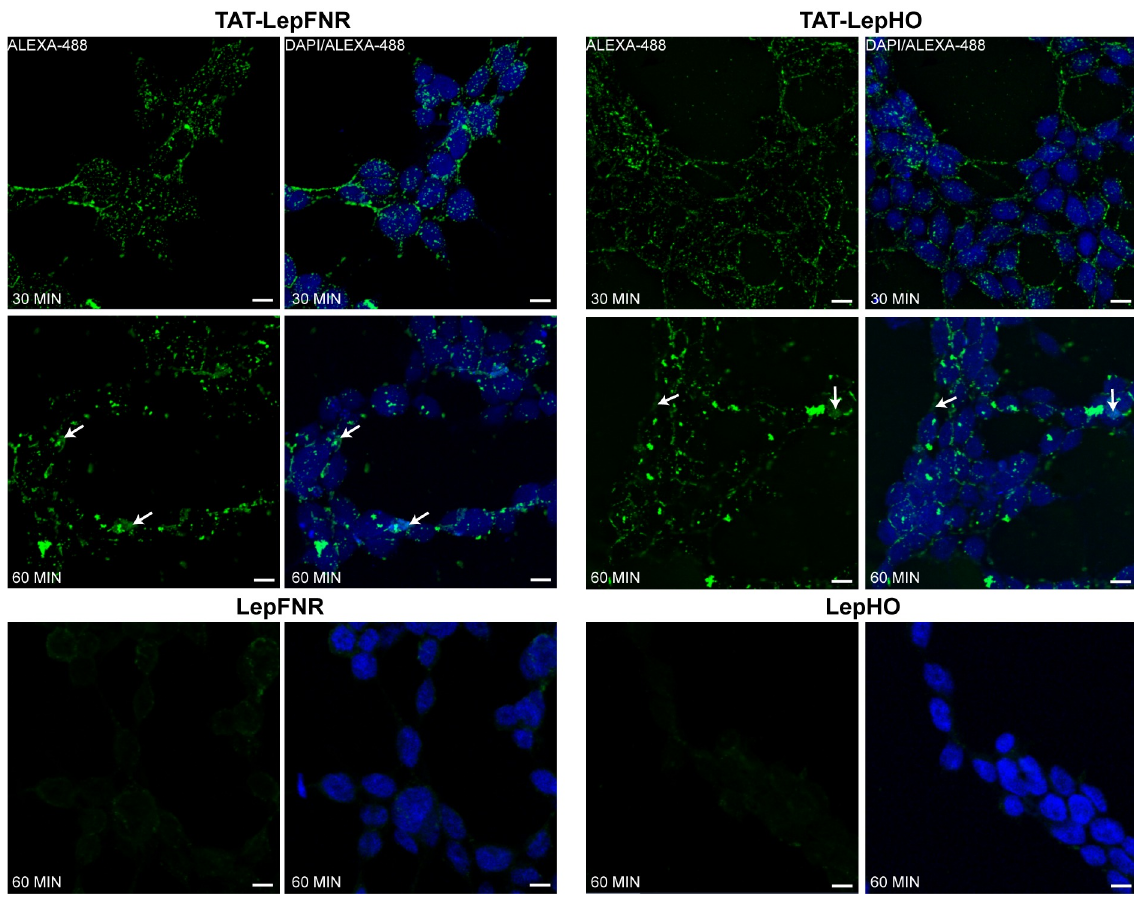
Fig 4. Immunofluorescencedetection of transduced proteins. Cells were incubatedwith 3 μ M TAT-LepHO/TAT-LepFNR for 30–60 min using LepHO and LepFNRas negativecontrols, respectively.Fixed and permeabilized cells were then incubatedwith primary anti-LepHO/LepFNR antibodies. The coverslipswere washed, incubatedwith the secondary Alexa-488conjugated antibody, and mountedwith ProLongwith DAPI. White arrows show diffuse green fluorescent areas. Confocal images were obtainedusing a Zeiss LSM 880 confocalmicroscopewith a 20X objective.Magnification: scan zoom x:3, y:3, scale bar 10 μ m.Zen image acquisitionsoftware (Carl Zeiss) was used to analyze images.